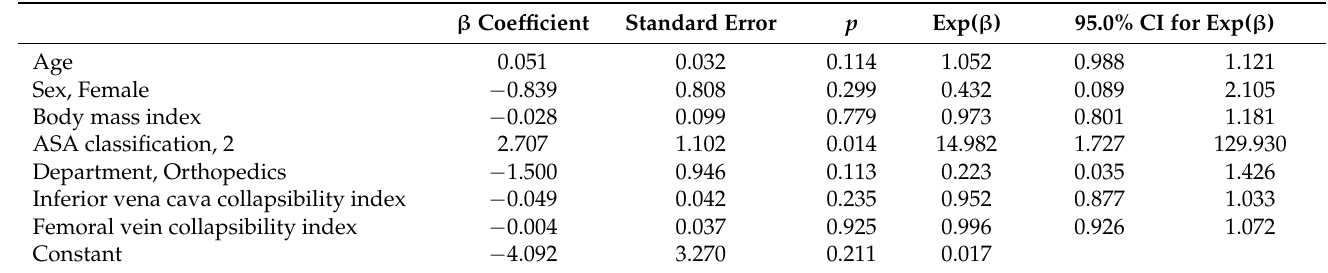
Table 3. Significant factors independently associated with hypotension, multiple logistic regression